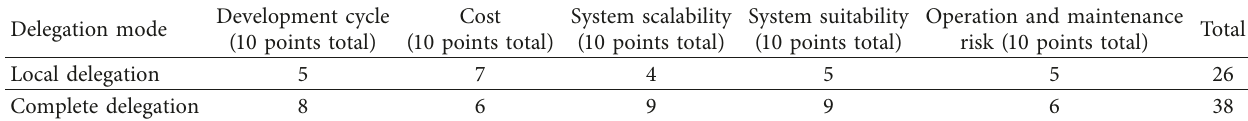
Table 2: Comparison table of influencing factors in the development